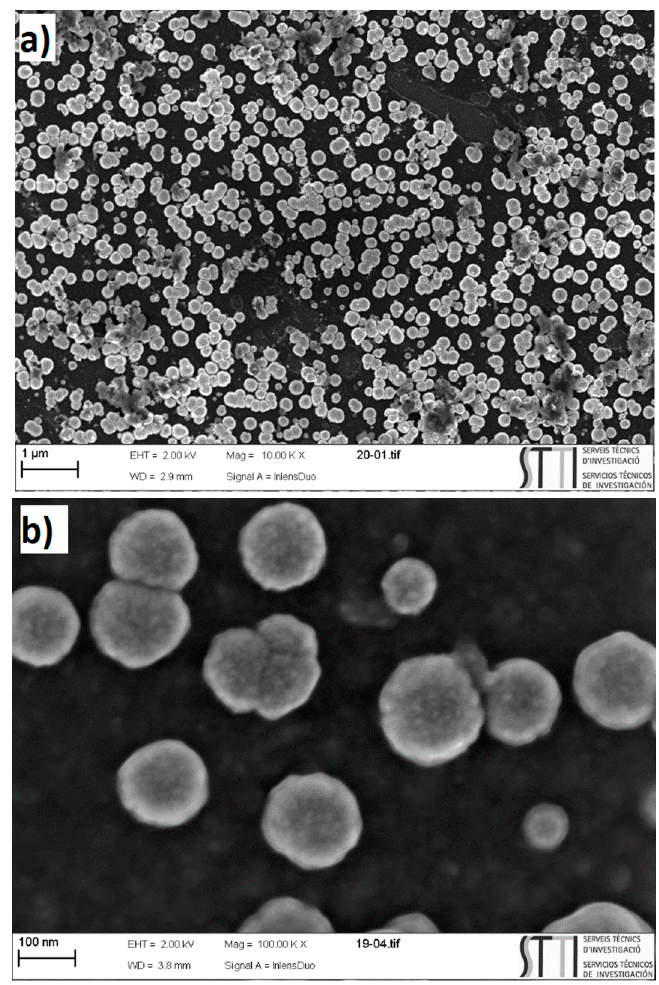
Figure 9. SEM micrographs of GC/PANI(CV)/PtNPs obtained with the following deposition conditions: E on = − 150 mV, E off = +100 mV, t on = 10 ms, and DC = 75%. 5mM K 2 PtCl 6 in 0.5 M H 2 SO 4 .